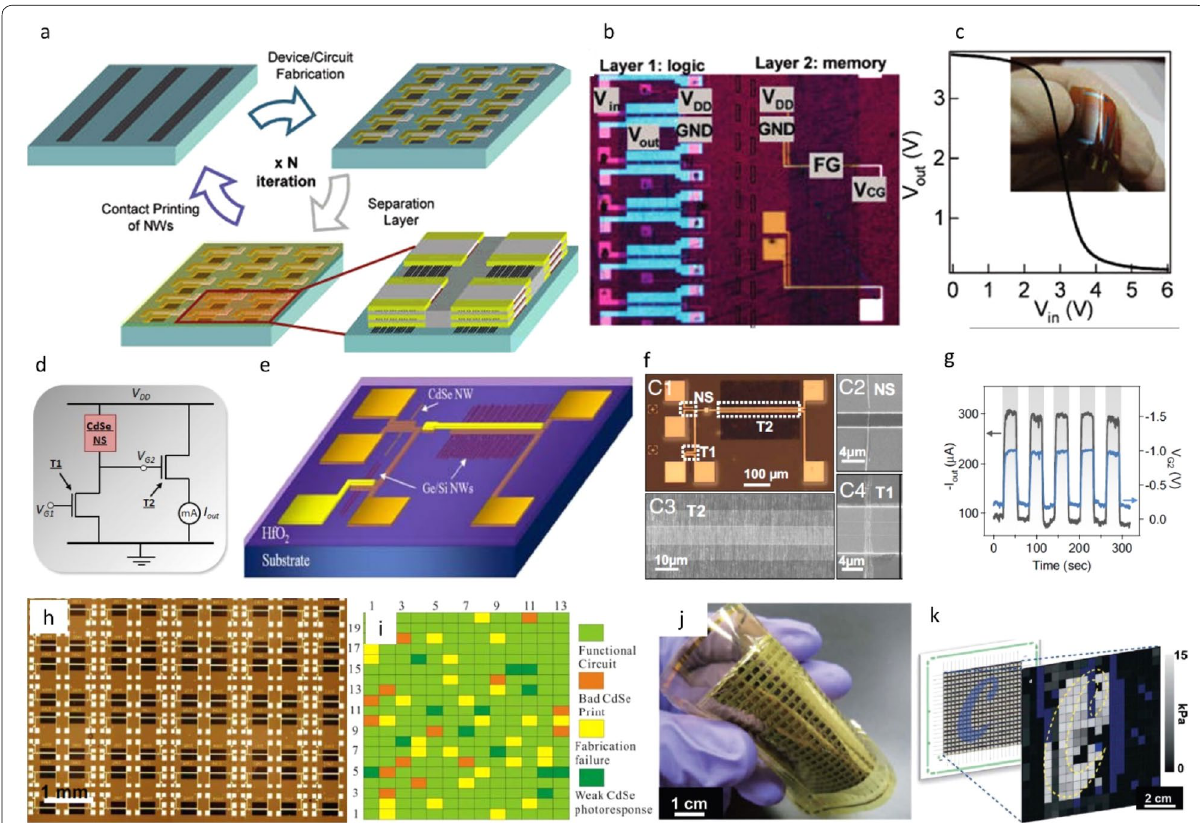
Fig. 14 Electronic circuits and systems developed using printed inorganic nano/micro scale structures: ( a – c ) 3D NW circuit integration and system [42]. a 3D NW circuit is fabricated by the iteration of the contact printing, device fabrication, and separation layer deposition steps N times. b Optical image of inverters (layer 1) and floating gate memory (layer 2) on Kapton. c DC inverter characteristics. Inset shows functional devices on flexible Kapton substrate. d – i Heterogeneous NW assembly for an all integrated, sensor circuitry [43]. d Circuit diagram for the all-NW PD, with high-mobility Ge/Si NW-FETs (T1 and T2) amplifying the photo response of a CdSe nanosensor. e Schematic of the all-NW optical sensor circuit based on ordered arrays of Ge/Si and CdSe NWs. f An optical image of the fabricated NW circuitry, consisting of a CdSe nanosensor [(C1), and (C2)] and two Ge/Si core/shell NW-FETs [(C3) and (C4)] with channel widths 300 µm and 1 µm, respectively. Each device element within the circuit can ≈ be independently addressed for dynamics studies and circuit debugging. g Circuit output current (blue curve) and voltage divider output voltage (grey curve) response to light illumination (4.4 mW/cm 2 ). h Optical image of an array of all-NW PD circuitry with each circuit element serving as